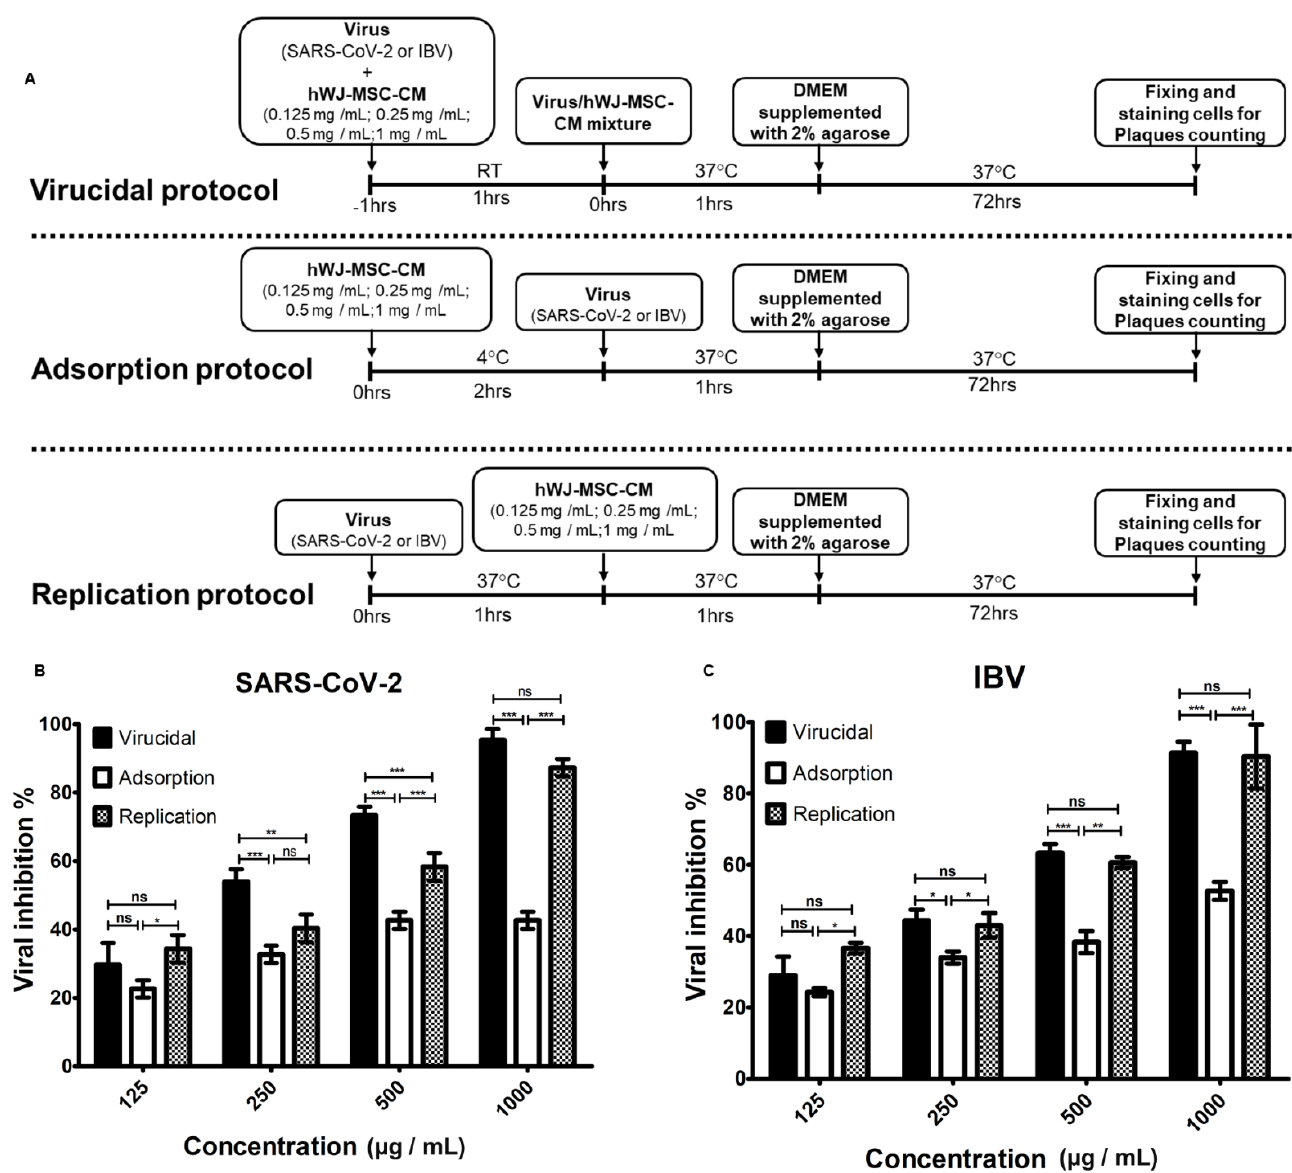
Figure 3. Antiviral mechanism of hWJ-MSC-S. ( A ) Schematic depicting the experimental protocols used for the assessment of antiviral mechanisms of hWJ-MSC-S. Virucidal, anti-adsorption, and anti-replication activities of hWJ-MSC-S against SARS-CoV-2 ( B ) and IBV ( C ) were evaluated in Vero E6 cells and measured by plaque reduction assay. Results are shown as means ± SD of three independent experiments, each run in triplicate. The p value; * p < 0.05, ** p < 0.01, *** p < 0.001 indicated the significant correlation among antiviral assays.